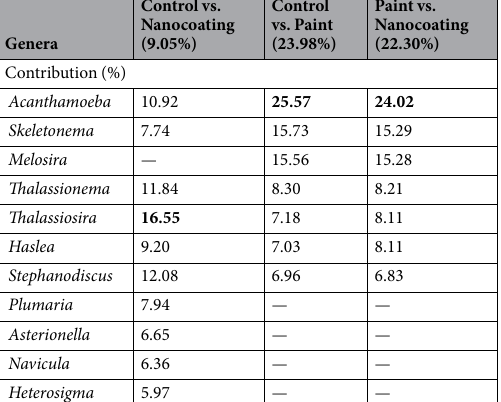
— — Table 2. SIMPER analysis for estimation of Eukaryotes genera contribution to total dissimilarity. The contribution of particular genera of eukaryotes towards the total dissimilarity (%) between the eukaryotic communities using SIMPER